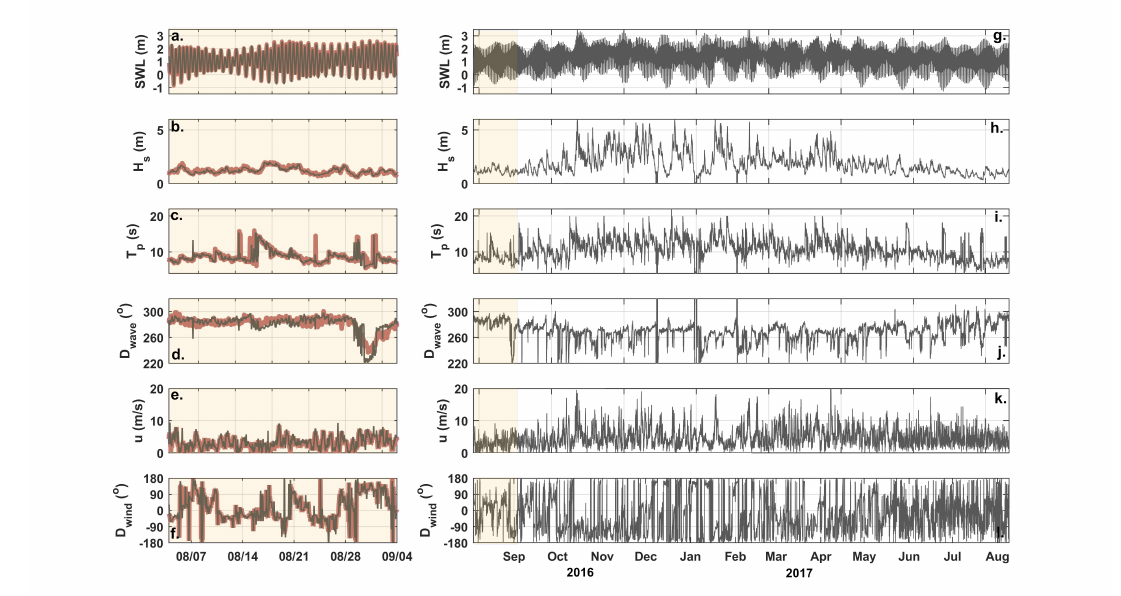
Figure 6. Locally measured (red) and transformed (grey) still water levels ( a ), significant wave heights ( b ), peak wave periods ( c ), wave direction ( d ), wind speed ( e ), and wind direction ( f ) for a 1 month period in summer 2016. The continuous, year-long time series of environmental parameters between summer 2016 and summer 2017, which includes the one-month period (shaded), for input to Windsurf is shown in panels ( g – l ) using the transformed variables, where applicable. Please note that, as per model core conventions, 270 ◦ is shore-normal for D wave (nautical convention) and 0 ◦ is shore-normal (onshore directed) for D wind